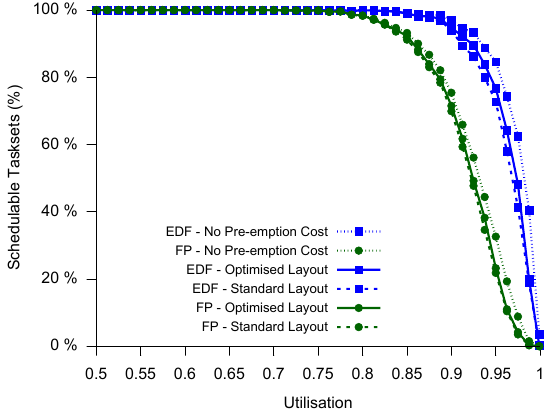
Figure 7 Percentage of schedulable tasksets at each utilisation level for the Mälardalen and SCADE benchmarks for tasksets of cardinality 10.